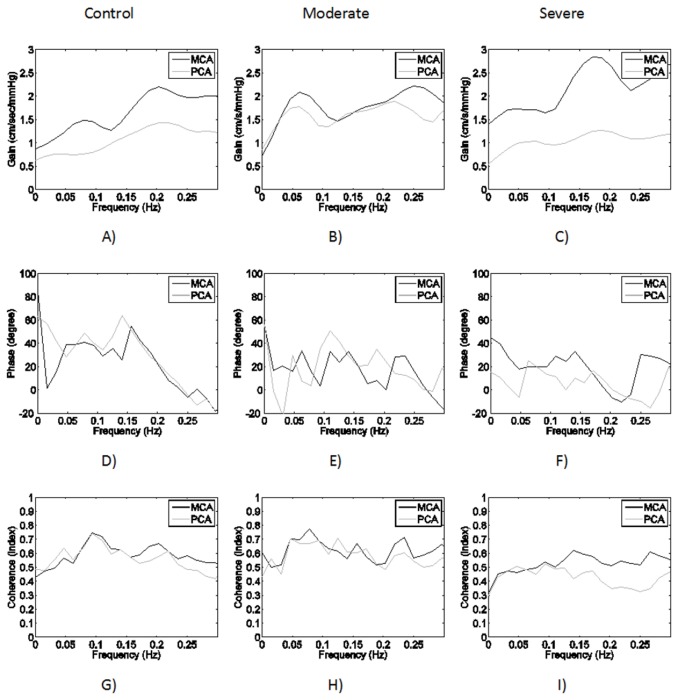
The group-averaged transfer function analysis for the subjects in three categories (control, moderate, and severe) is plotted.The coherence (H-I) between 0.06-0.12 Hz exceeds 0.5 for all conditions, indicating TFA is valid to describe the recorded hemodynamics as linear systems. Control: A) High-pass gains were obtained for both MCA (dark line) and PCA (gray line). D) Large positive phase difference between blood flow velocity and arterial blood pressure in 0.06-0.12 Hz was observed for both MCA and PCA. Moderate: B) The gains are increased in MCA and PCA when comparing with the controls, implying the amplitudes of blood flow velocity follow ABP more passively than the controls. E) The phase in MCA and PCA is reduced. Severe: C) The gains of MCA and PCA move separately. In particular, the gain of PCA becomes flat and low, whereas the gain of MCA is increased. F) Positive phase in MCA is still preserved. However, it is close to zero in PCA, suggesting CA is severely impaired.